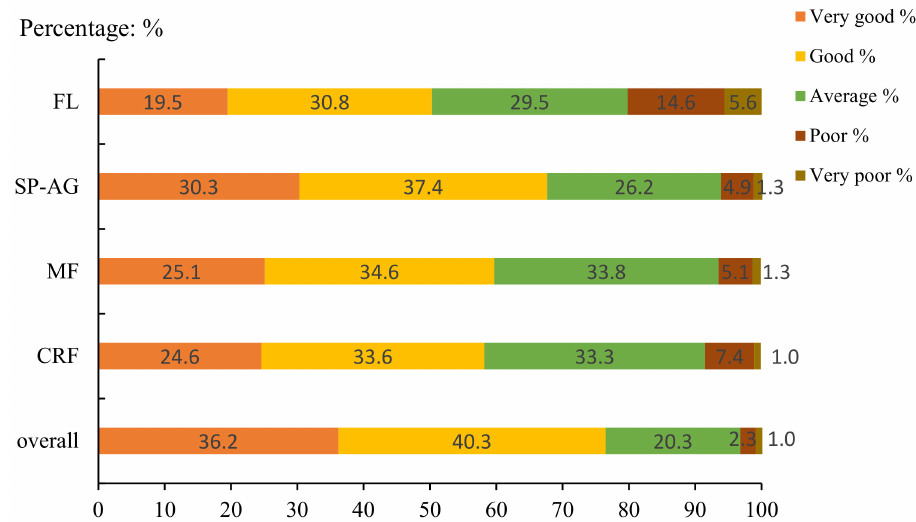
Figure 1. Distribution of responses by categories of self-reported physical fitness in children (CRF = cardiorespiratory fitness; MF = muscular fitness; SP–AG = speed and agility; FL = flexibility).